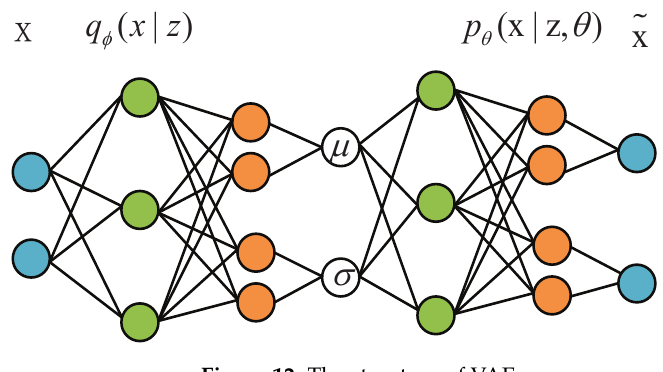
Figure 12. The structure of